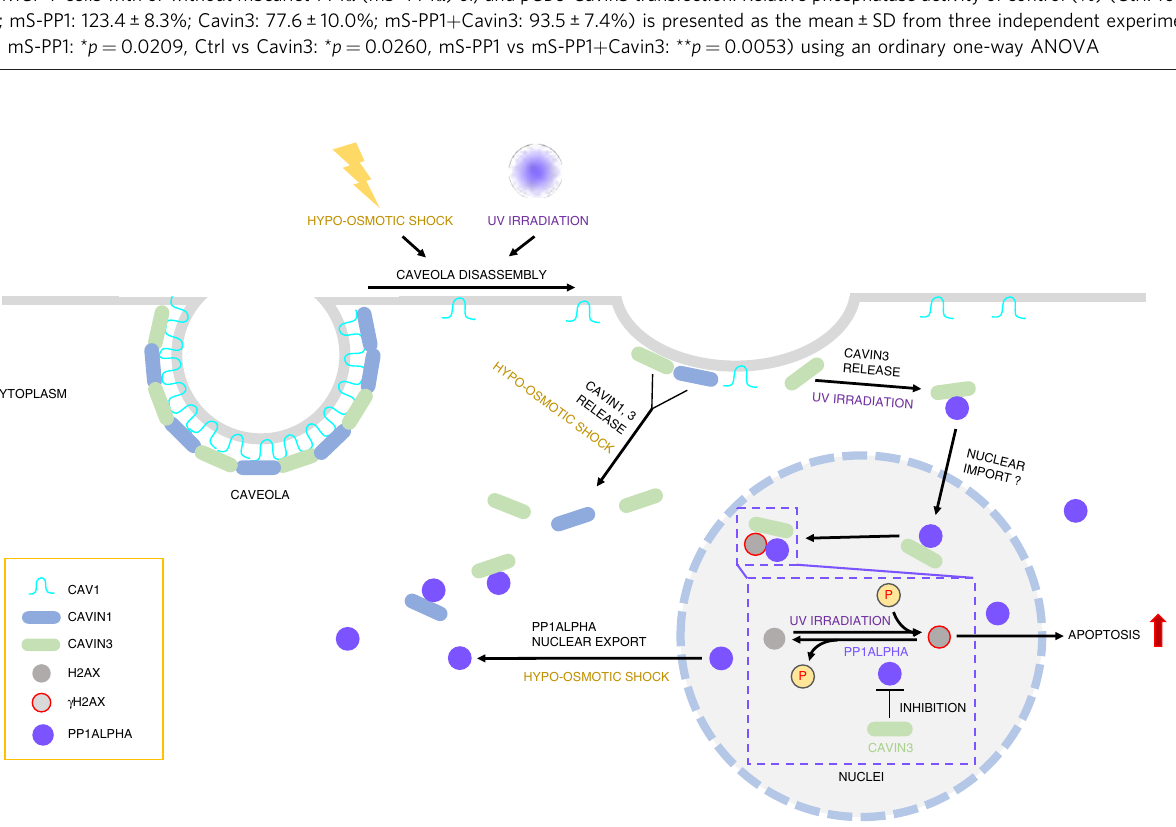
Fig. 7 Schematic of the interaction and function of cavins and PP1 α in response to stressors. In A431 cells (Cavin2-de fi cient), hypo-osmotic treatment induces redistribution of cavins and PP1 α to the cytosol from plasma membrane caveolae and the nucleus, respectively, to allow interaction of these proteins. In addition, UV treatment led to the dissociation of Cavin3 from caveolae. We propose that the released Cavin3 may interact with the cytosol pool of PP1 α fi rst and be subsequently recruited to the nucleus as Cavin3-PP1 α complex to associate with γ H2AX. In the nucleus, Cavin3 exerts a proapoptotic role by promoting H2AX phosphorylation and its downstream apoptotic signaling through the interaction with and inhibition of PP1 α , which has been identi fi ed as a direct phosphatase for γ H2AX (phospho-H2AX) in this